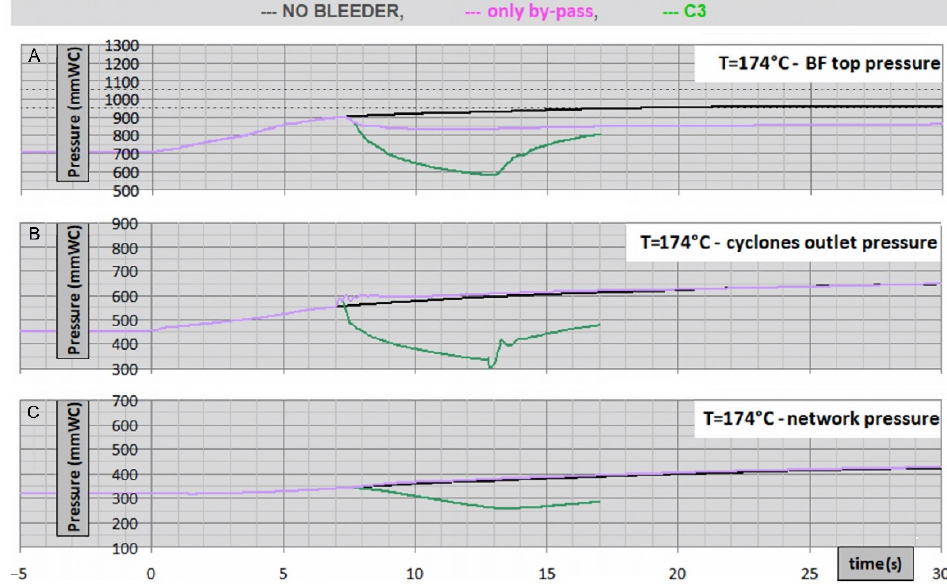
Figure 18. Evolution over time of pressure in the circuit with by-pass opening at 850 mmWC without Clean Relief Valve and C3 compared with the no bleeders case in a low severity event. ( A ) BF top pressure; ( B ) cyclones outlet pressure; ( C ) network pressure.